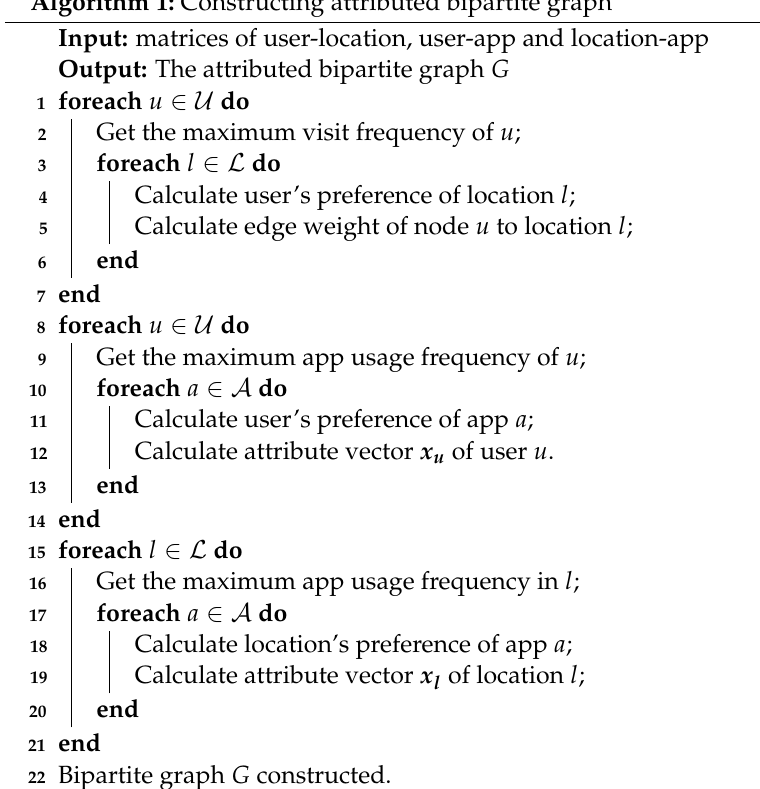
Algorithm 1: Constructing attributed bipartite graph